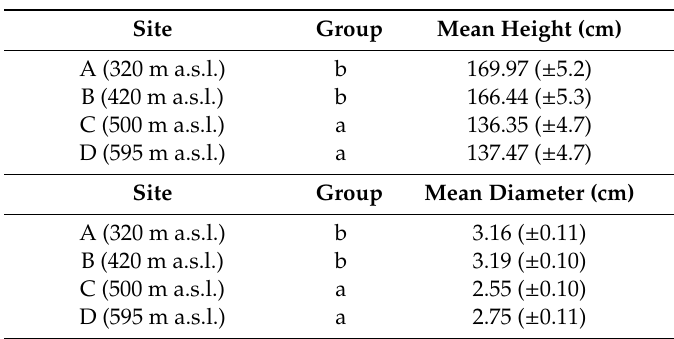
Table 3. Results of the post hoc tests used to assess the di ff erences in tree height and diameter in all four sites. Values were measured at the start of the growing season (23 May). “Group” letters identify significantly ( p < 0.05) di ff erent groups, where “a” is the group with the lower value. Corresponding mean height (cm) and diameter (cm) values are also shown for each site. Values in brackets represent the standard error